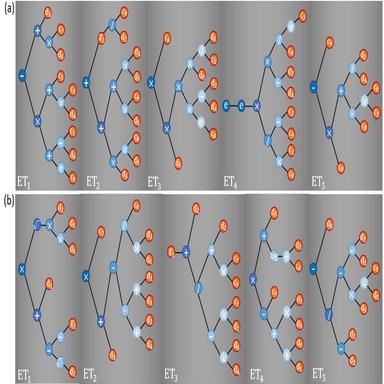
Expression trees of the optimal design models for the (a) tensile stiffness and (b) effective postbuckling compressive stiffness of the EC-enabled metastructures at ET1, ET2, ET3, ET4, and ET5 (ET = Sub − ETi for all the cases).